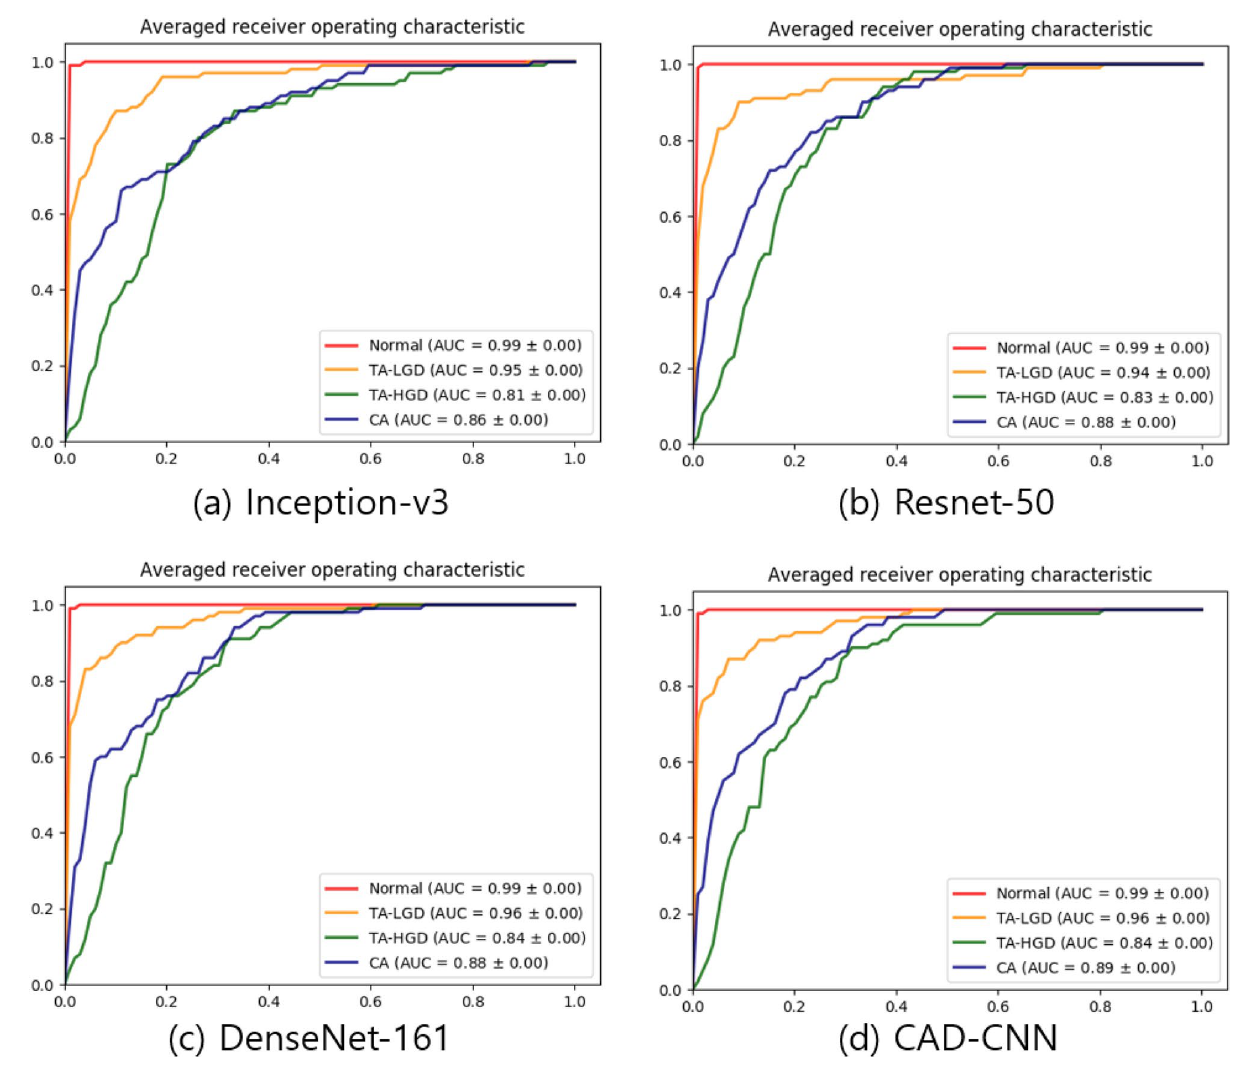
Figure 7. Receiver operating characteristics (ROCs) curves of test results with the HYUMC data set. The 10 CV models which show the best validation accuracy during 300 training epochs with the KUMC data set are evaluated. The area under curve (AUC) is also listed for each category. ( a ) Inception-v3. ( b ) Resnet-50. ( c ) DenseNet-161. ( d )